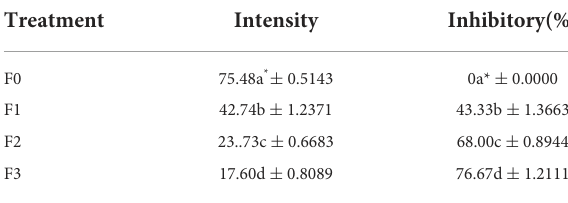
TABLE 5 The inhibition of treatment of N. oryzae on Bali red rice in greenhouse.